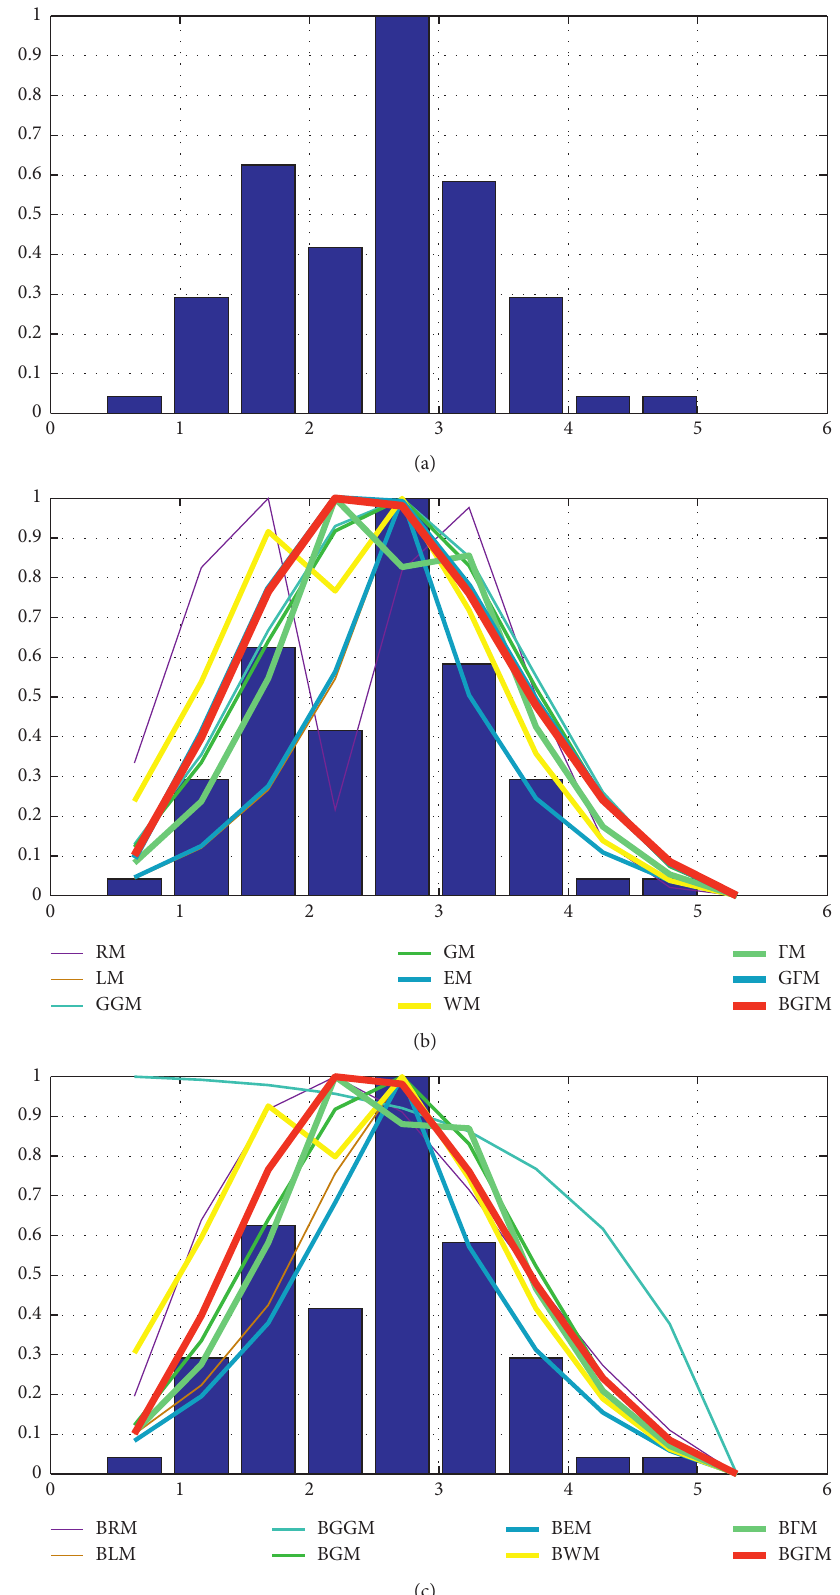
Figure 9: The estimated histogram. (a) The histogram of the tensile strength of 100 observations of carbon fibers; (b) the estimated histogram of RM, LM, WM, GM, EM, GGM, Γ M, G Γ M, and G Γ M; (c) the estimated histogram of BRM, BLM, BWM, BGM, BEM, BGGM, B Γ M, and BG Γ